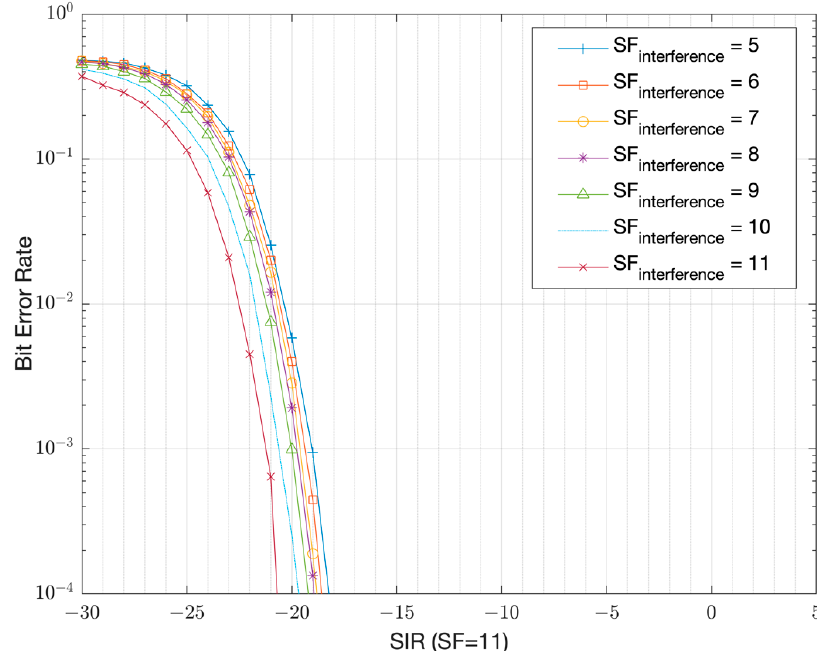
Figure 6. BER versus SIR with IQ inversion with SF ‐ 11 (500 kHz bandwidth) .